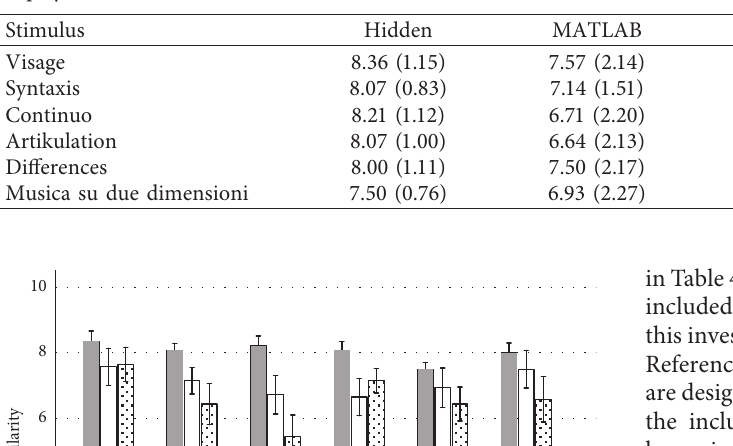
Table 4: Descriptive statistics of similarity ratings by stimulus and filter type for the reduced participant sample size ( n � 14). Results are displayed as mean (standard deviation).